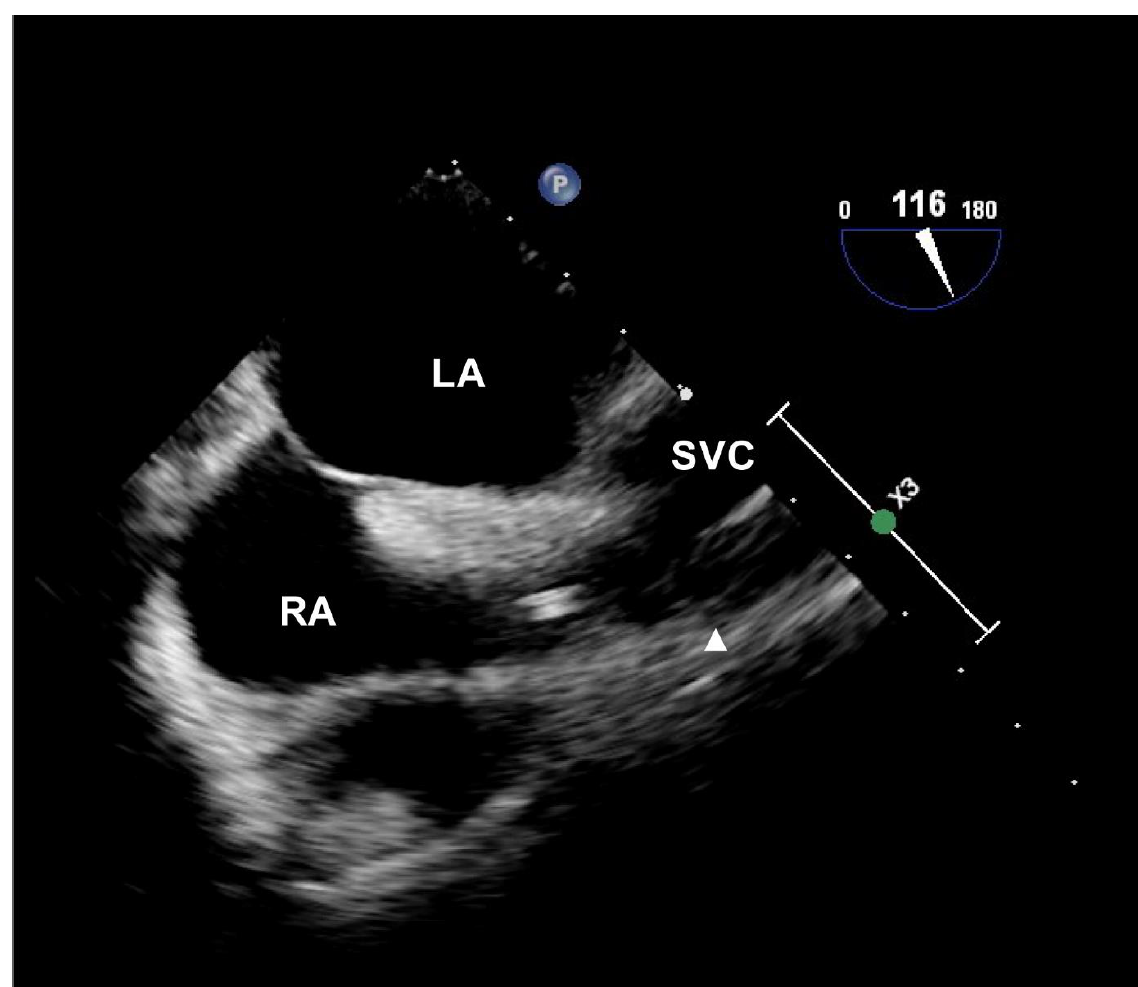
Figure 2. Echocardiographic image of catheter tip positioning. The catheter tip is identified as two parallel echogenic lines from the bicaval view. The solid triangle indicates the level of the upper border of the crista terminalis, defined as the echocardiographic junction of the SVC and the RA. Abbreviations: LA, left atrium; RA, right atrium; SVC, superior vena cava.